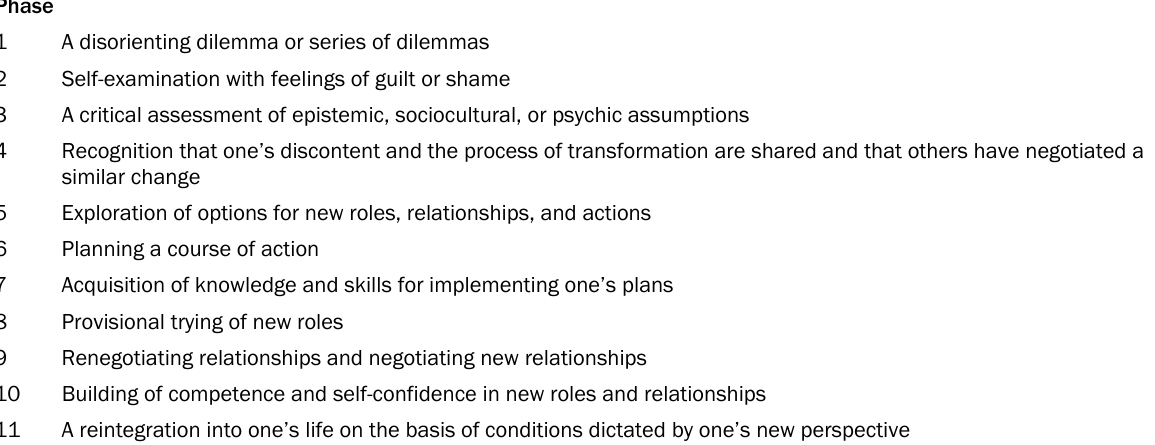
Table 1. The Phases of Transformative Learning